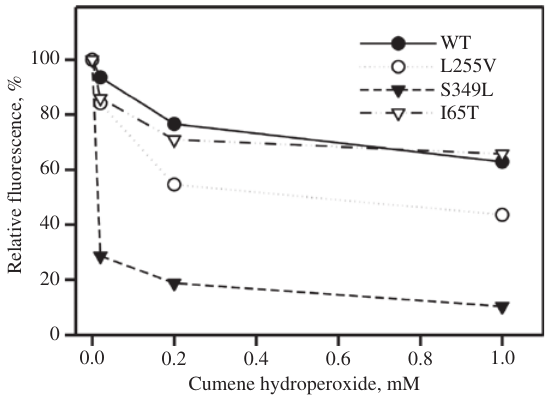
Figure 2: FACS analysis of cumene hydroperoxide effect. The transformed cells cultured in FM medium were treated with the indicated amounts of cumene hydroperoxide for 4 h and subjected to FACS analysis. The fluorescence levels were relative to those of the corresponding non-treated cells. The data shown is representa- tive of two independent